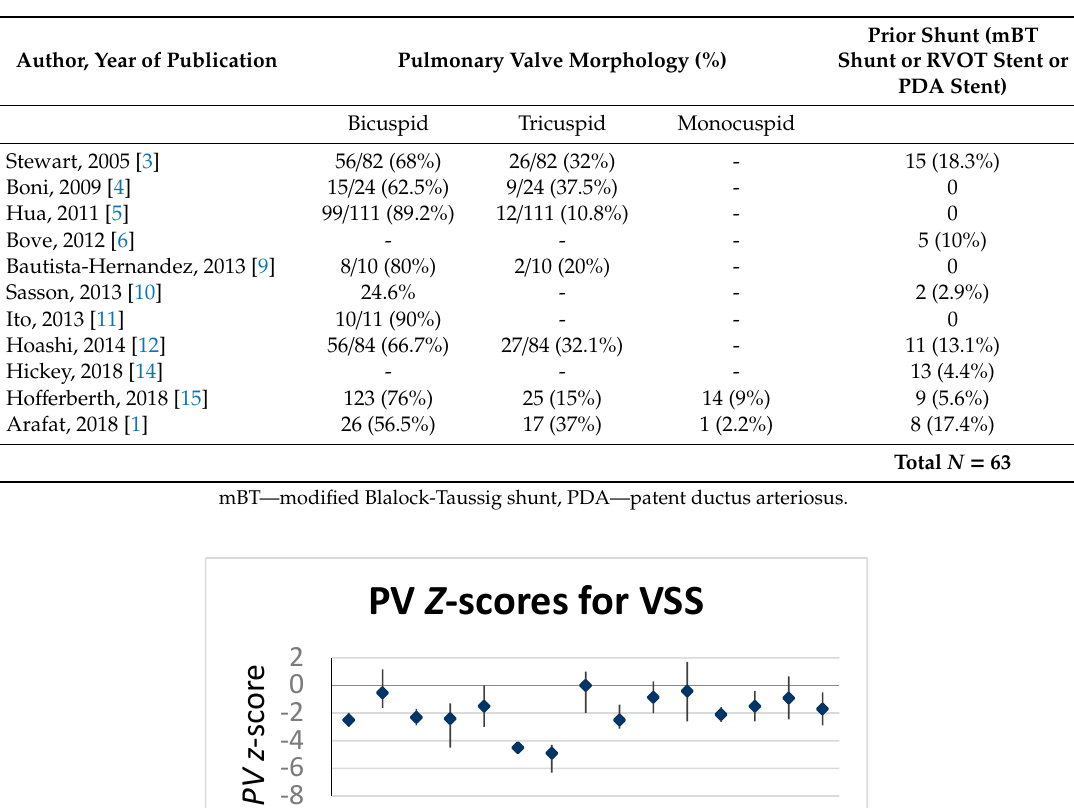
Table 2. Pulmonary valve morphology and number of shunts.